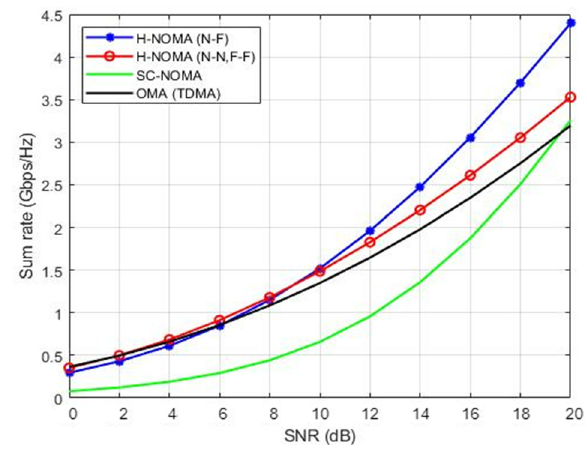
Figure 5. H-NOMA techniques vs. NOMA/OMA.